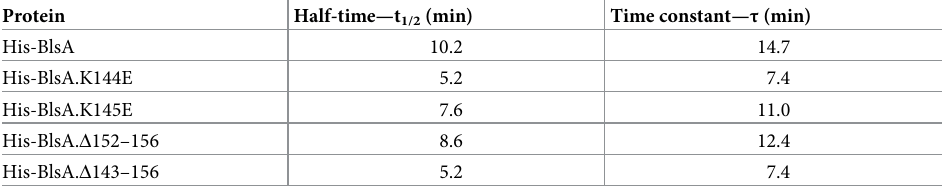
Table 2. Kinetic values for light-to-dark recovery of His-BlsA and derivatives generated by site-directed point and deletion mutations.